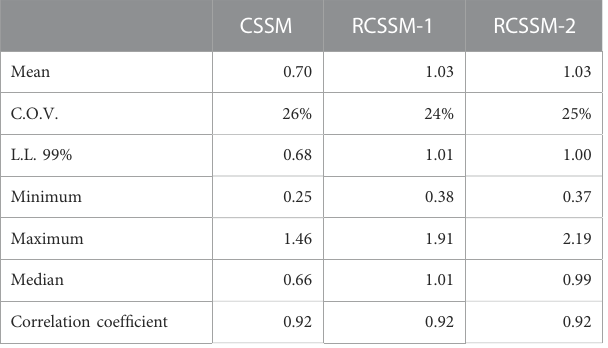
TABLE 5 Statistical measures for calculated SR for proposed